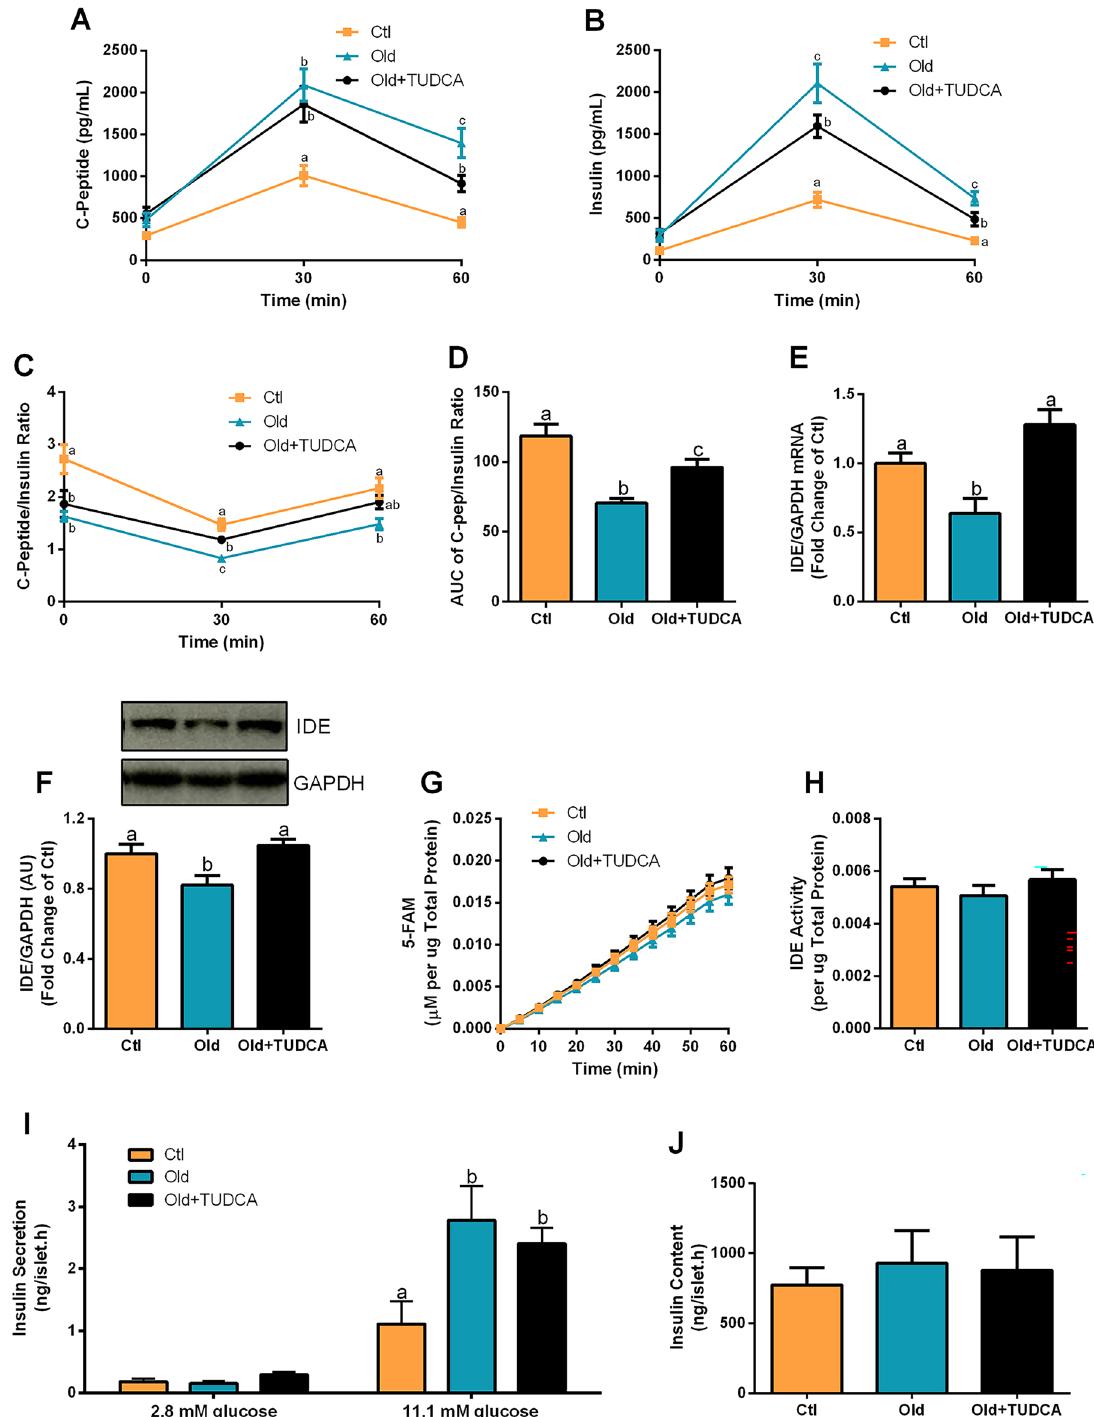
Figure 4. Effects of TUDCA treatment upon insulin clearance and secretion. Plasma c-peptide ( A ), insulin ( B ), and c-peptide/insulin ratio ( C ) before (0 min), 30 and 60 min after the glucose administration, and AUC of plasma c-peptide/insulin ratio ( D ). Gene expression of IDE ( E ), and protein content of IDE ( F ) in the liver, both normalized by GAPDH. Kinetic of the IDE activity assay ( G ) and total IDE activity ( H ) in the liver. Fluorescent intensity at Ex/Em = 490/520 nm was continuously recorded, every 5 min, for 60 min. 5-FAM concentration was calculated using a standard curve and normalized per μg of total protein in the liver. Insulin secretion of isolated pancreatic islets after 1 h incubation with 2.8 and 11.1 mM glucose ( I ) and total insulin content per islet ( J ). Data are presented as mean ± SEM (n = 5–10). Statistical analysis was performed using the one-way ANOVA test, followed by Tukey post-hoc-test. Letters shared in common between groups indicate no significant difference. Different letters (a, b, and c) indicate statistical difference between groups (P ≤ 0.05). AU arbitrary